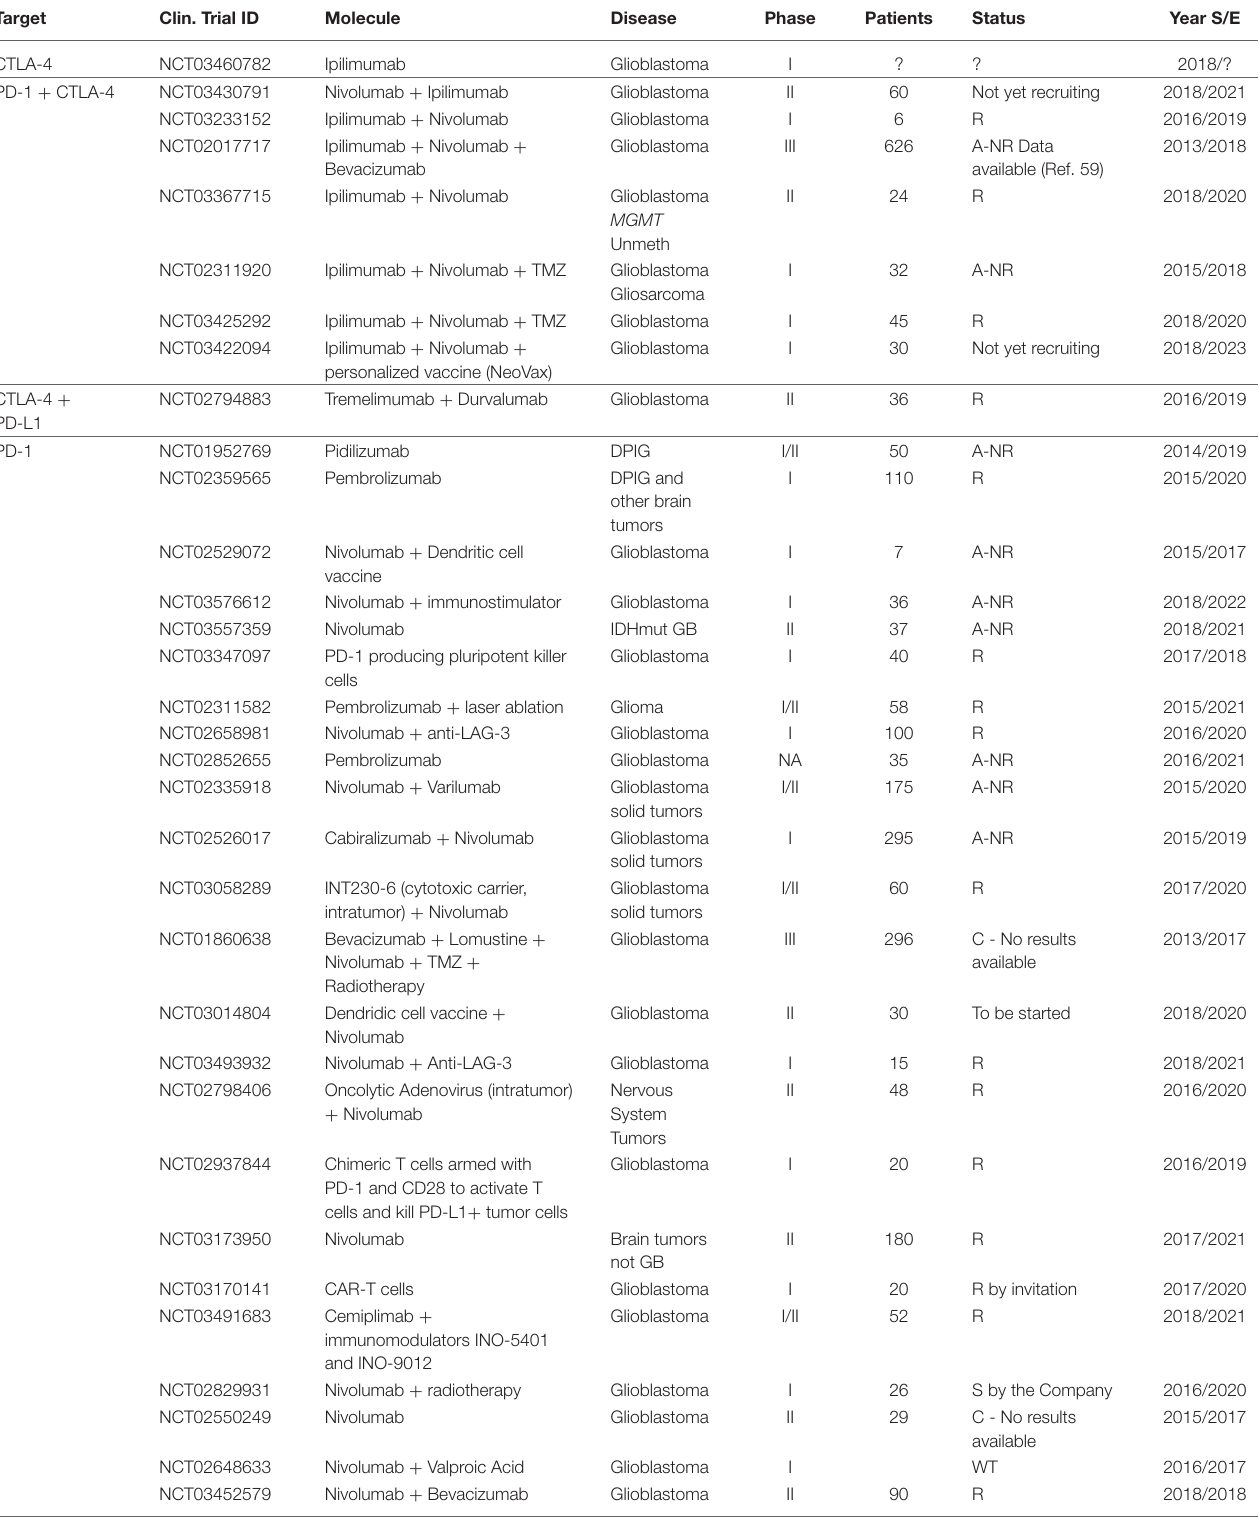
TABLE 1 | Clinical trials with IC inhibitors in glioma (July,